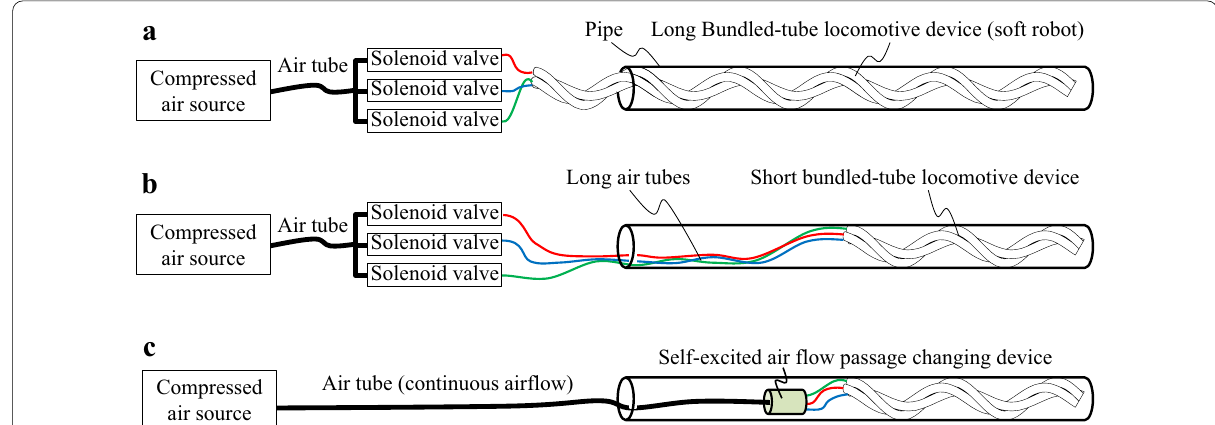
Fig. 1 Problem associated with a long traveling soft robot. a Problem associated with long soft robot. b Problem when air supply tubes become long. c Concept of the self-exciting airflow passage changing